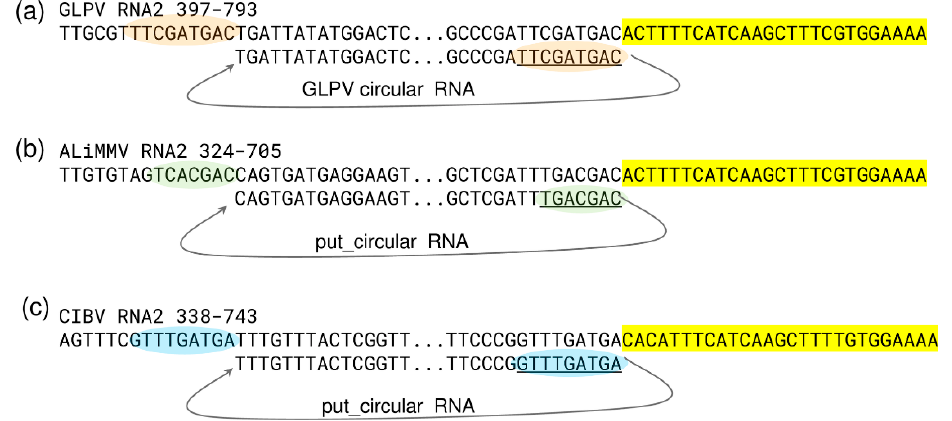
Figure 7. Nucleotide sequence analysis of the site of origin of the circular RNAs in anulaviruses. Nucleotides sequence alignments showing conserved regions (antiparallel) found at initiation and termination sites of the circular RNA in ( a ) GLPV (orange) and predicted in ( b ) ALiMMV (green) and in ( c ) CIBV (blue), together with conserved nucleotide stretches flanking these sites in the RdRP (highlighted in yellow).